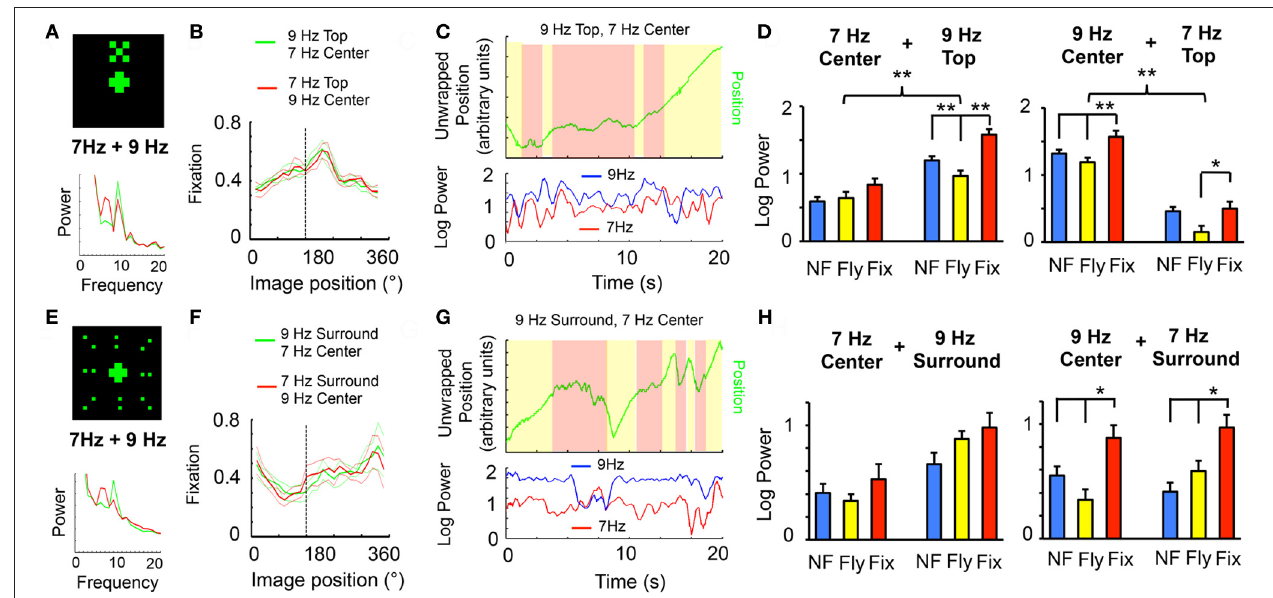
FIGURE 2 | Visual competition. (A) A 30 ◦ -wide “X,” composed of 20 LED pixels flickering together at 7 or 9Hz, was positioned above a centrally-positioned cross (as in Figure 1 ), also flickering at 7 or 9Hz. Sample power spectrum is shown in the lower panel (green, 9Hz top, 7Hz center; red, reversed tags). (B) Flies were able to fixate on this compound object (dashed line shows frontal position), in either frequency combination (red vs. green, as indicated). (C) Ongoing analysis of 7 and 9Hz power during fixation in a sample fly. (D) Left panels: Log-normalized 7 or 9Hz power ( ± SEM) for the three behavioral states (NF, blue, not flying; Fly, yellow, flight without fixation; Fix, red, flight with fixation) when 7Hz is center and 9Hz is top. Right panels, the same with swapped frequency tags. n = 6 male wild-type flies; ∗ P < 0 . 05, ∗∗ P < 0 . 01, ∗∗∗ P < 0 . 001 by t- test. 9Hz and 7Hz groups